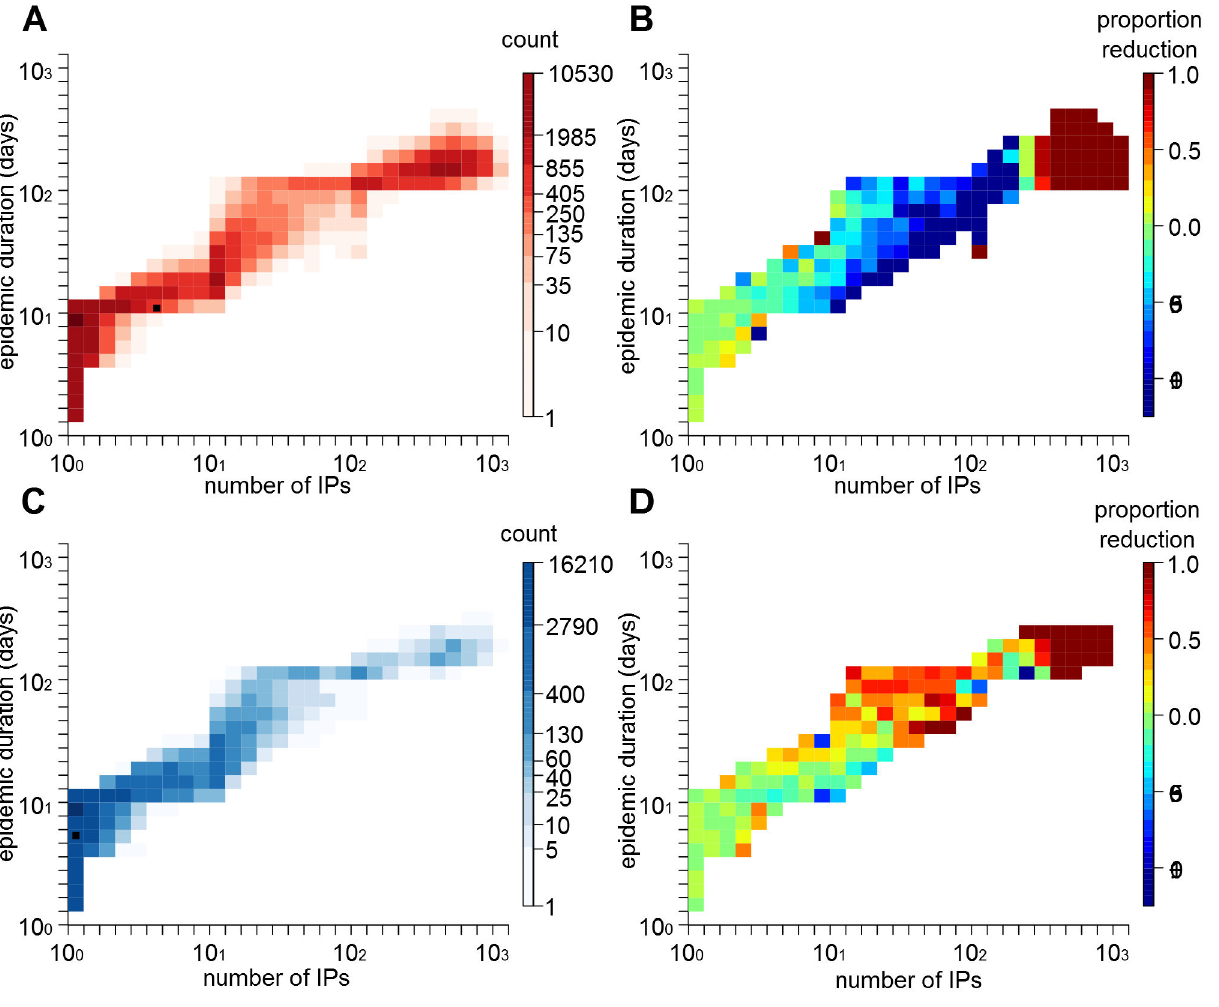
Figure 3. Epidemiologic impacts of a single FMD incursion when routine control measures are implemented alone or together with vaccination. A and C show the number of premises infected (IP) in a given epidemic generated from a single incursion in Southern (A) and Northern (B) counties, versus the number of days that epidemic would last. B and D show the the proportion reduction in the number of epidemics when vaccination is implemented in the field at day 7 and for incursions in Southern (B) and Northern (D) counties. Black rectangle in A and C marks the geometric mean of the number of IPs and epidemic duration for all epidemics generated from incursions in the Southern or Northern counties, respectively. Negative values in B and C indicate an increase in the number of epidemics compared to when no vaccination is implemented, while positive values indicate a decrease in the number of